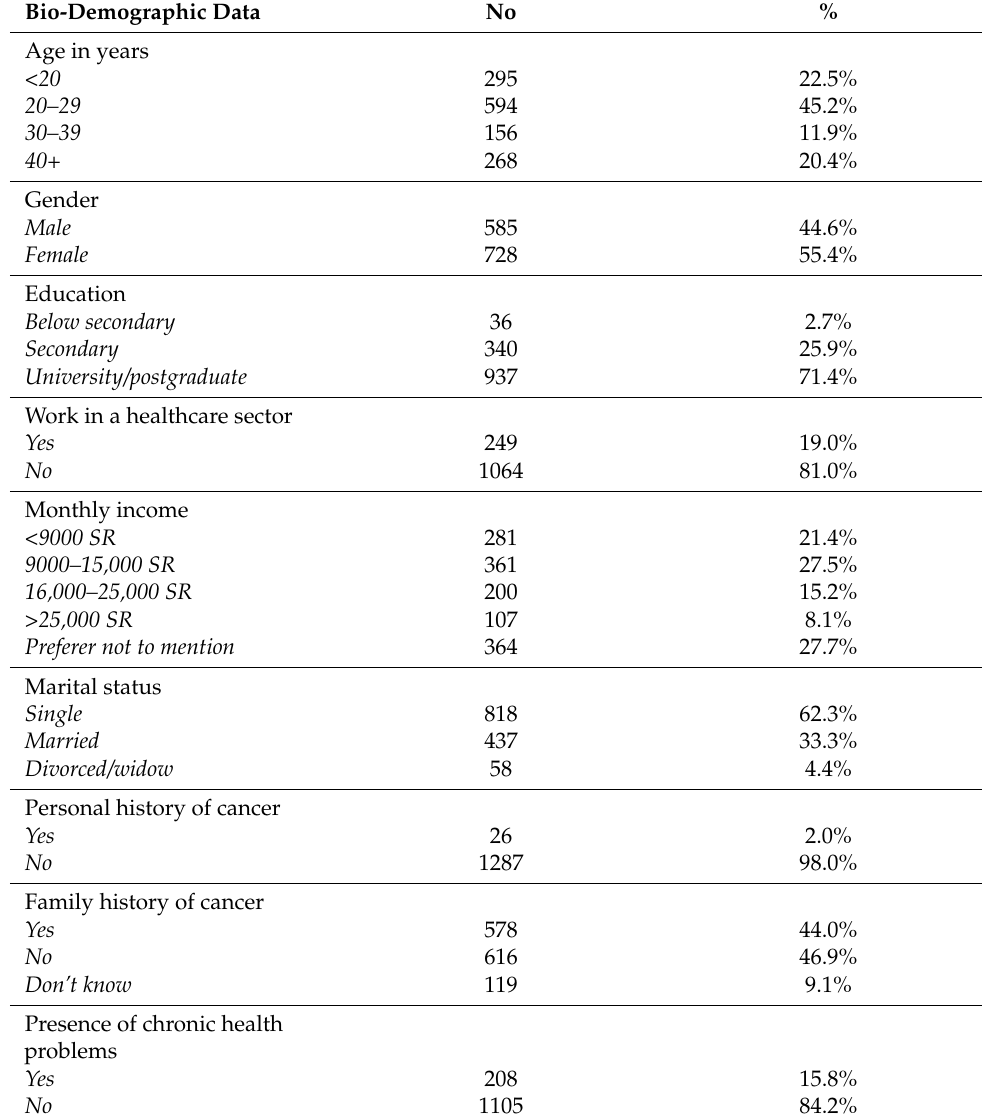
Table 1. Bio-demographic data of study participants, Saudi